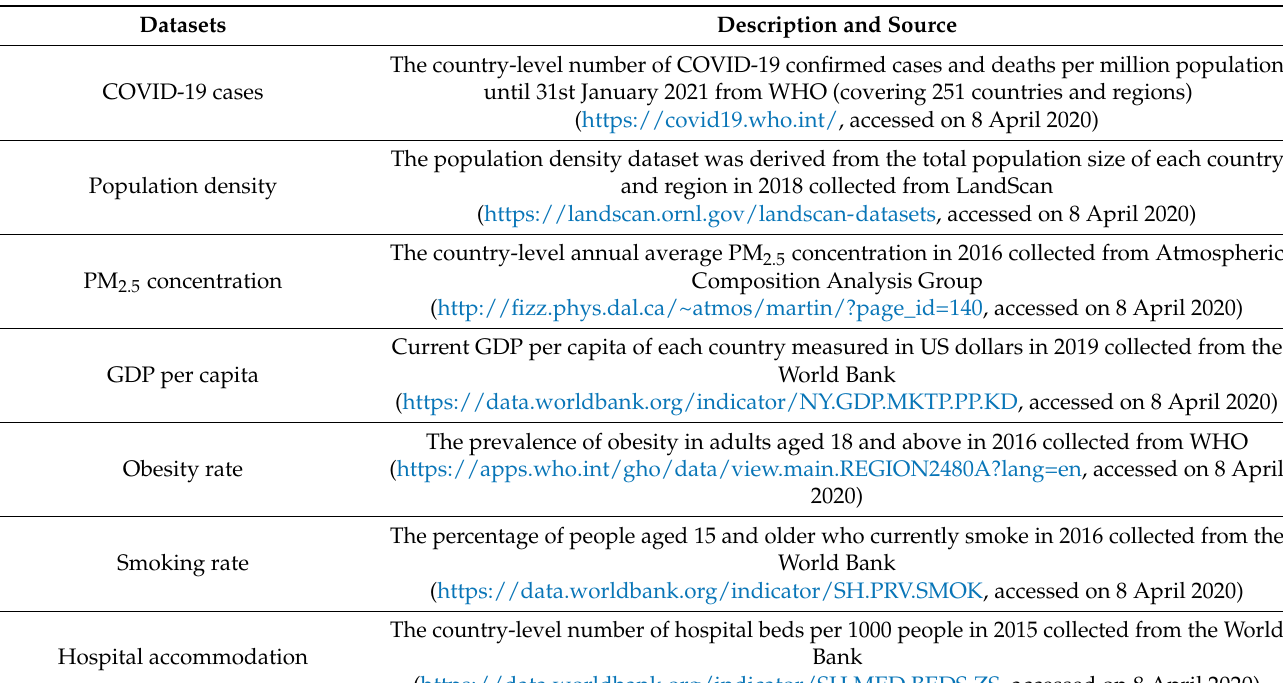
Table 1. Publicly available data sources used in this